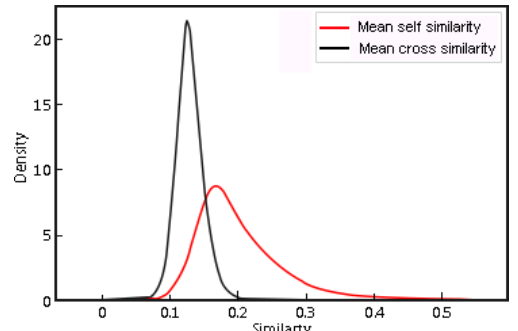
Fig. 4 Distribution of the mean similarities of slices. The curves show slices in the same domain belonging to the same class, which corresponds to the same bit in the target